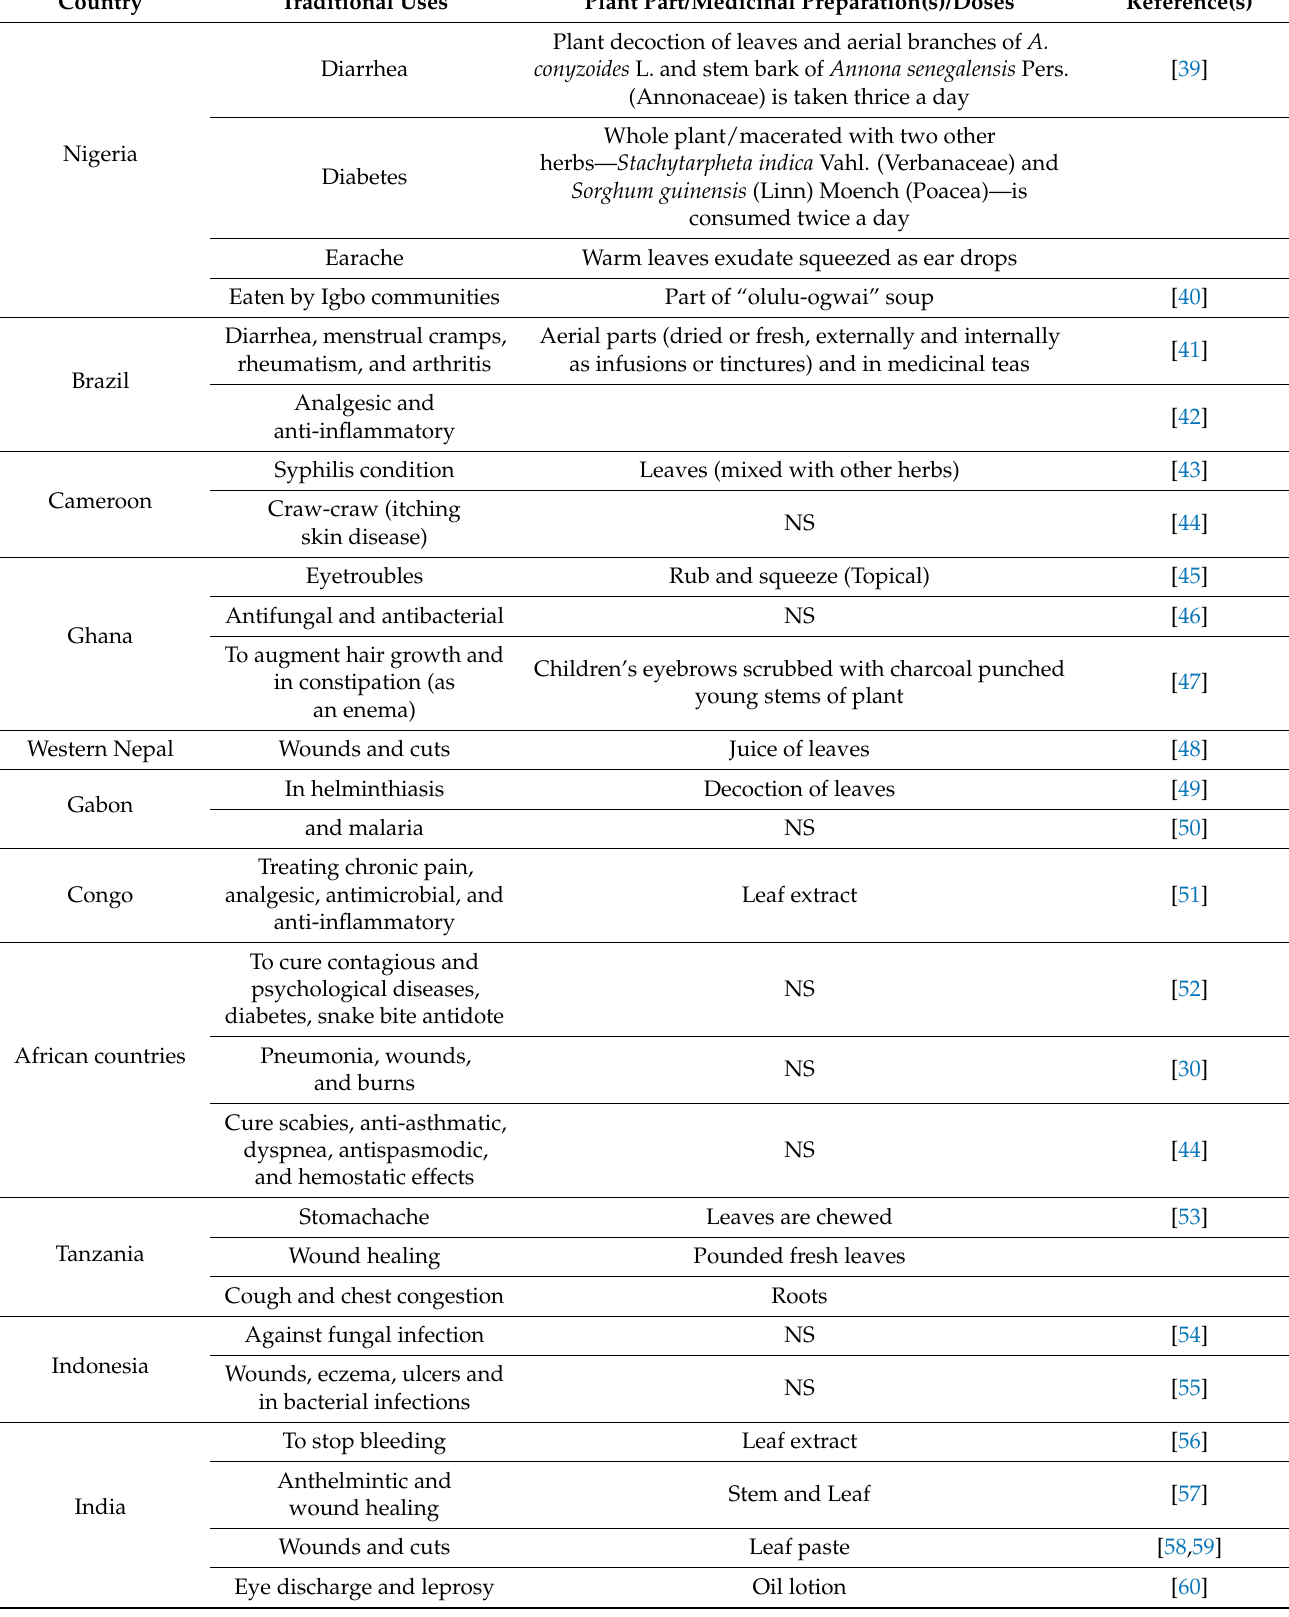
Table 1. Traditional uses of Ageratum conyzoides